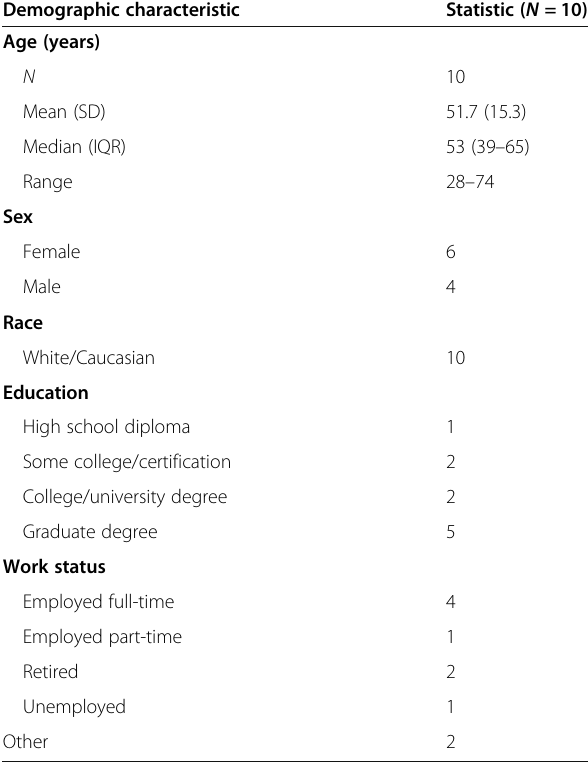
Table 1 Demographic characteristics of participants in the content validity study of the TASQ-IV and TASQ-SC measures Demographic